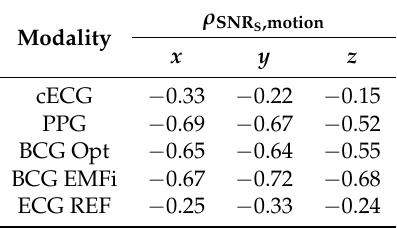
Table 3. Correlation coefficient between SNR S and the RMS motion with respect to the x , y , and z coordinates.